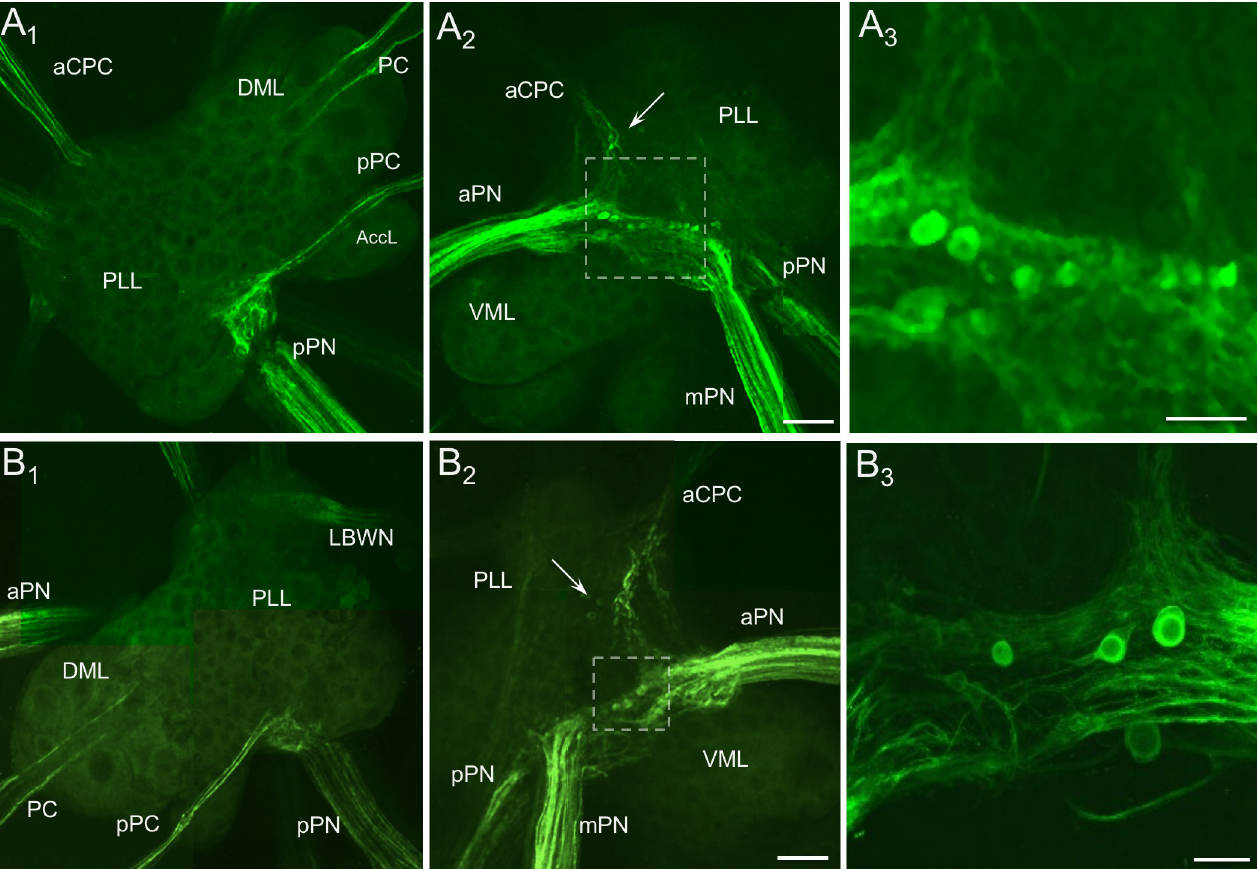
Fig 4. THli in the pedal ganglia. (A 1 , B 1 ) Dorsal surfaces of the left and right pedal ganglia, respectively. Immunoreactive fibers were present in each of the nerves and connectives, but no THli cell bodies were observed. (A 2 , B 2 ) Ventral surfaces of left and right pedal ganglia, respectively. THli fibers were abundant in the anterior and medial pedal nerves (aPN, mPN). Labeling was also observed in 8–10 and 4–6 small (10–30 μ m) neurons at the confluence of the aPN and mPN in the left and right ganglia, respectively. Several additional small THli neurons (10–15 μ m) were situated just lateral to the anterior cerebropleural connective (aCPC; arrows). Calibration bar = 200 μ m, applies to A 1 , A 2 , B 1 , and B 2 . (A 3 , B 3 ) Higher magnification of the regions enclosed by dashed boxes in A 2 and B 2 , respectively. The neurons embedded in the fiber tract exhibited diverse sizes and staining intensities. Calibration bar for A 3 = 100 μ m; calibration bar for B 3 = 50 μ m. Abbreviations: AccL, accessory lobe; DML, dorsomedial lobe; LBWN, lateral body wall nerve; pPC, parapedal commissure; PC, pedal commissure; PPL, posterior lateral lobe; pPN, posterior pedal nerve; VML, ventromedial lobe.